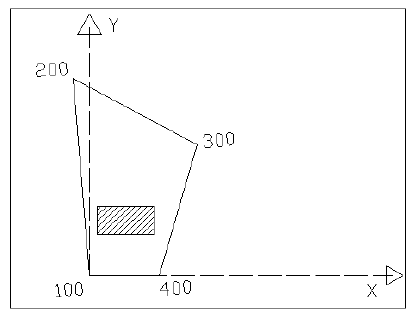
Figure 8. Control vertices located on the East side